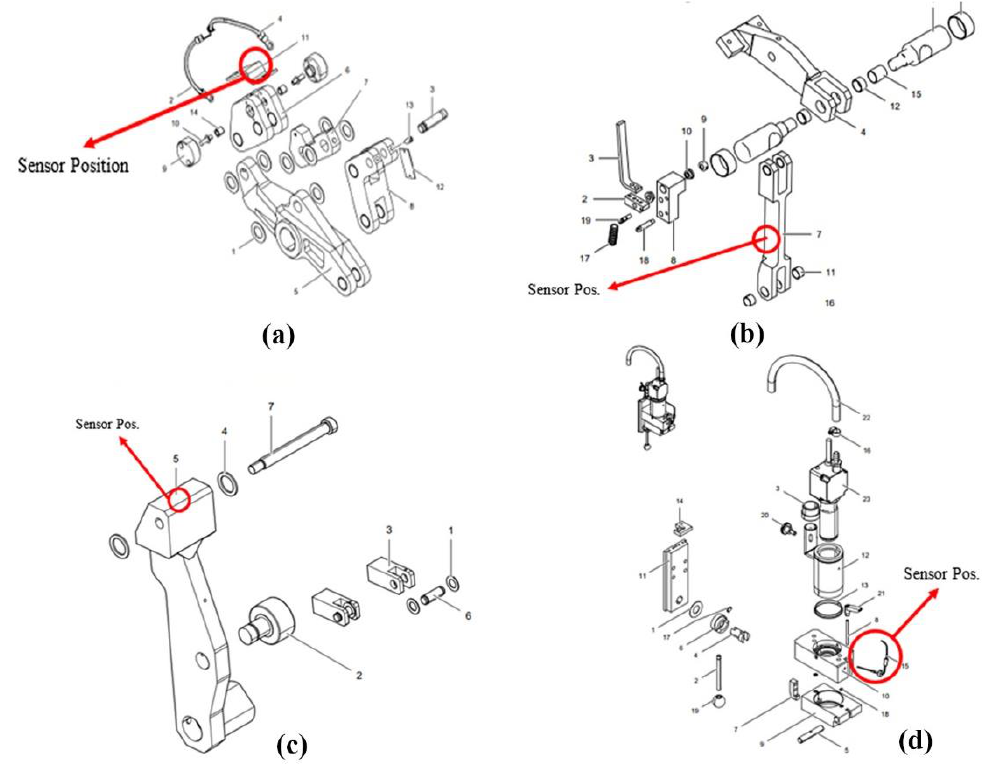
Figure 4. Sensor placement on tube filling— ( a )filling pump drive, ( b ) filling pump lever, ( c ) coding cam lever, ( d ) hot air station, thermocouple [35].